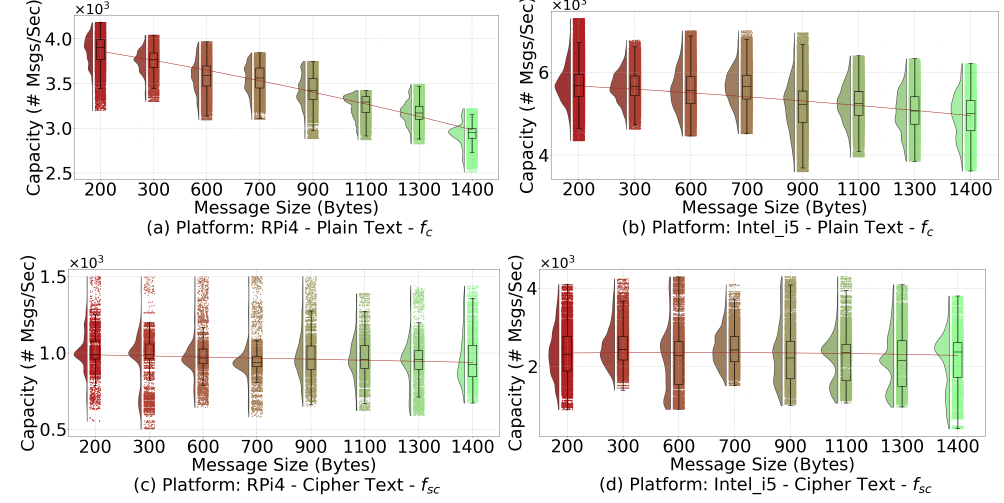
Figure 9. Raincloud plots for f c and f sc on two platforms: RPi4 and Intel_i5. The regression lines from these plots enable us to determine f c and f sc using the message size as